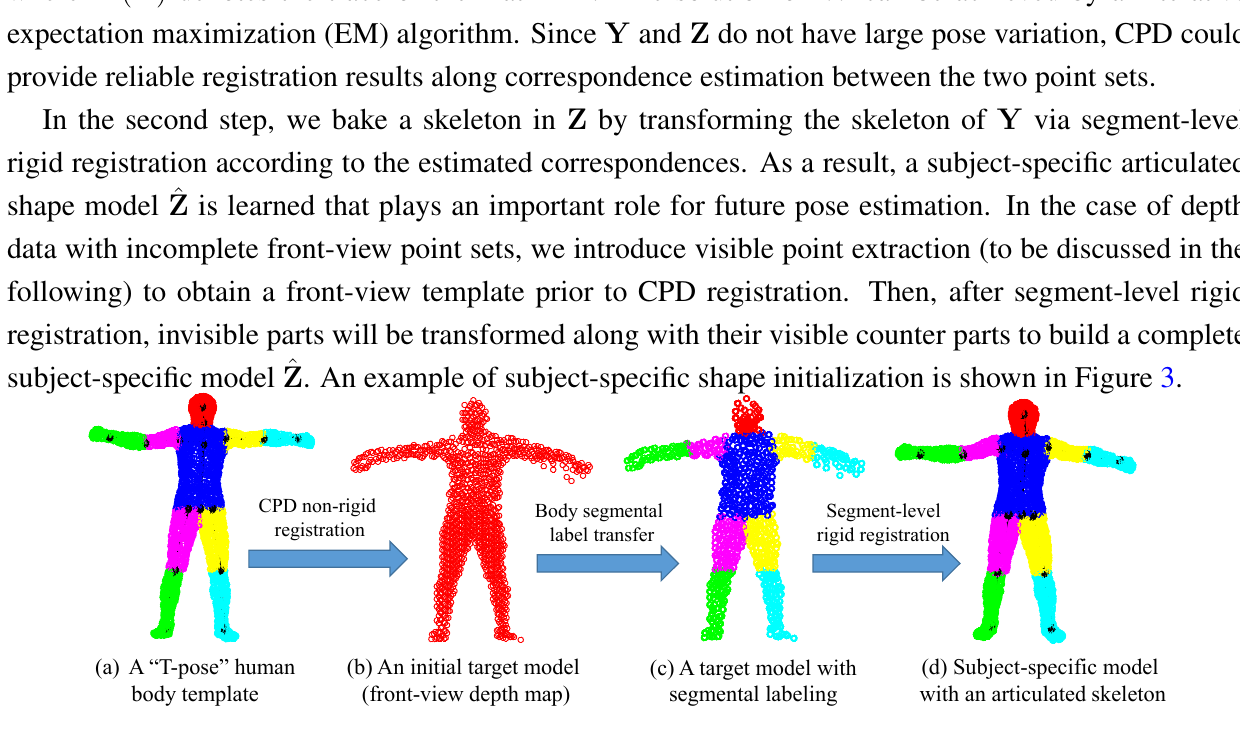
Figure 3. Subject-specific articulated body shape